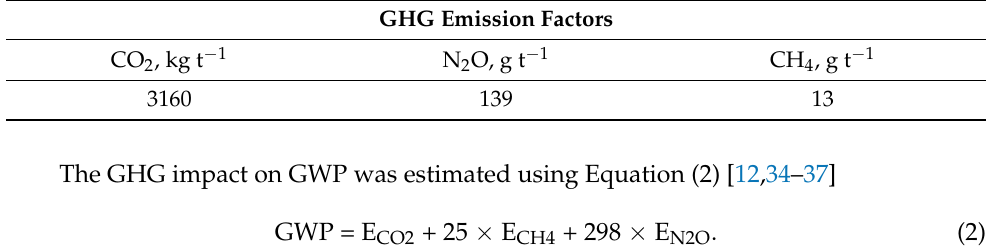
Table 1. Greenhouse gas (GHG) emission factors in agricultural transport using diesel fuel.